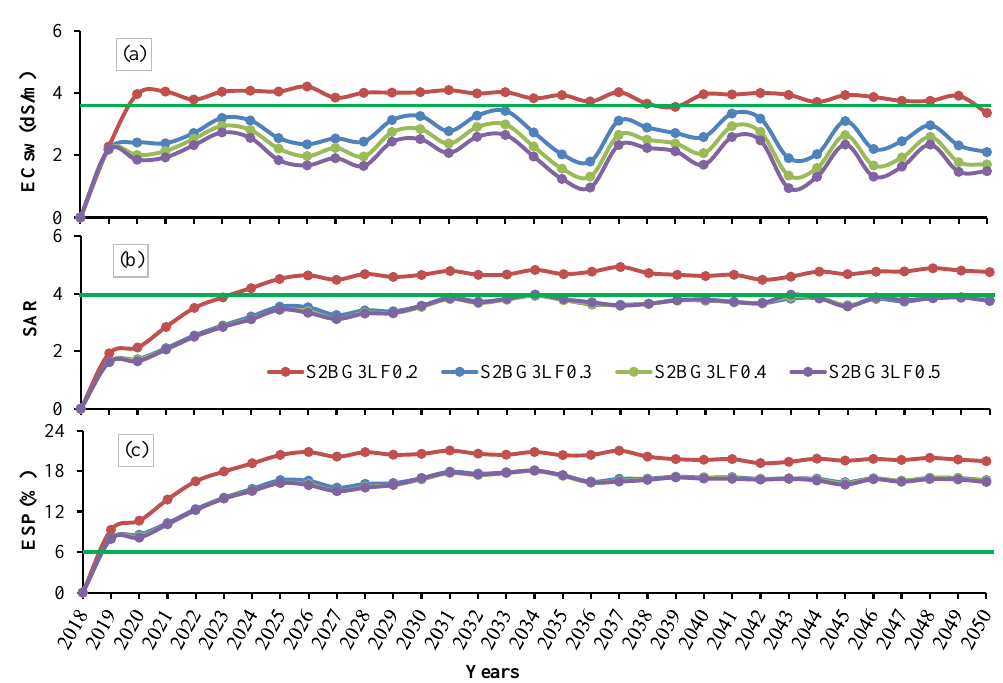
Figure 14. Impact of different leaching fractions (LF0.2, LF0.3, LF0.4, and LF0.5) and annual gypsum applications of 8.6 t/ha (G3) on ( a ) EC sw , ( b ) SAR, and ( c ) ESP in the 30–60 cm soil layer of the hard red-brown soil under a 1:1 blend of recycled (RW) and good water (GW) irrigation of almonds.